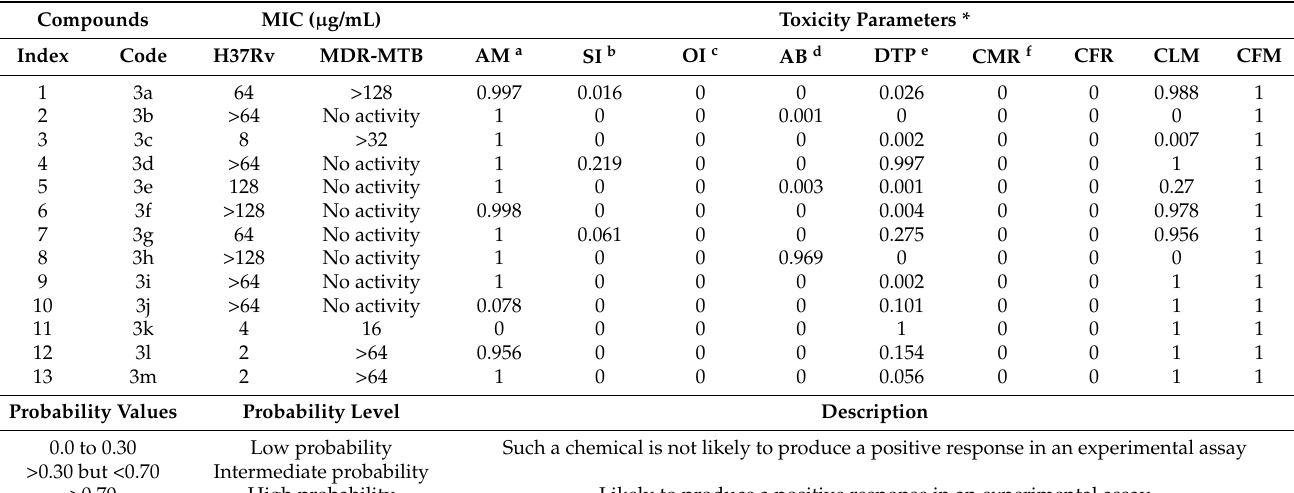
Table 4. Calculated toxicity